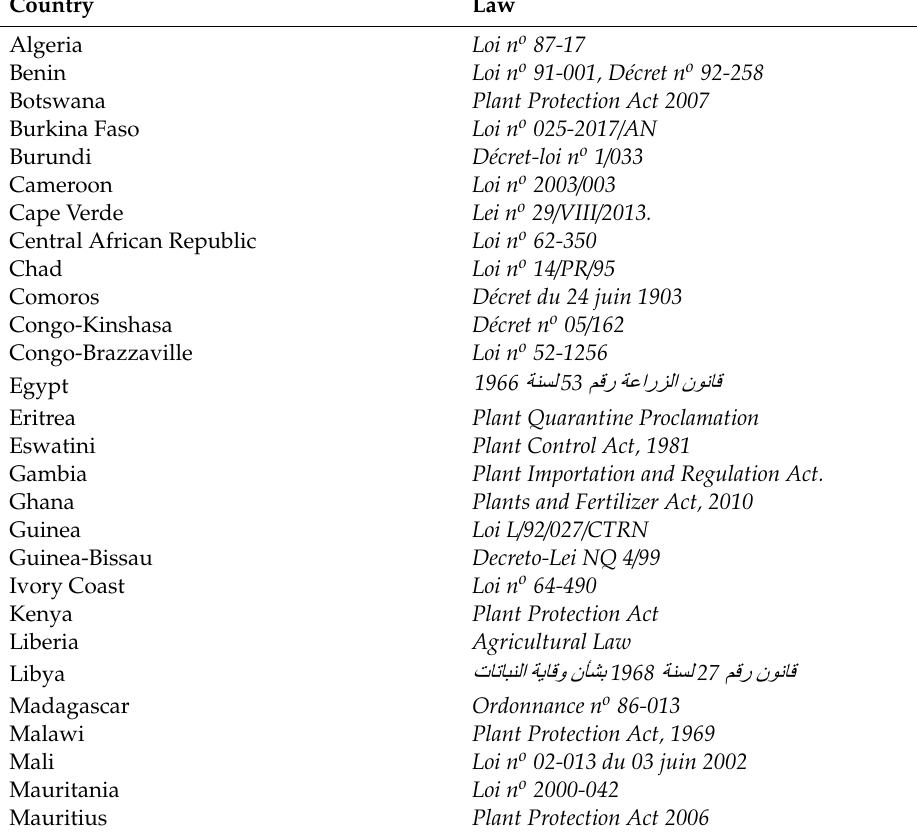
Table 6. Pest insect legislation pertaining edible insect species (contained in “all pest insect species”); No data could be obtained for Angola, Djibouti, Equatorial Guinea, Ethiopia, Gabon, Lesotho, Senegal, Sierra Leone, Somalia, South Sudan, Sudan, and Togo. Country Law Algeria